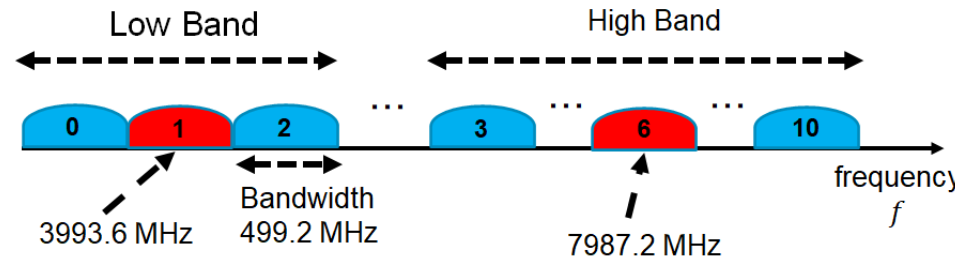
Figure 1. Operating frequency bands for the IEEE 802.15.6 UWB PHY.